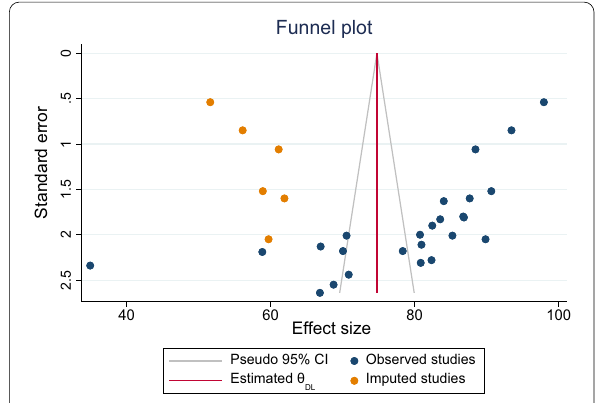
Fig. 4 Showing studies added by the trim-and-fill analysis of